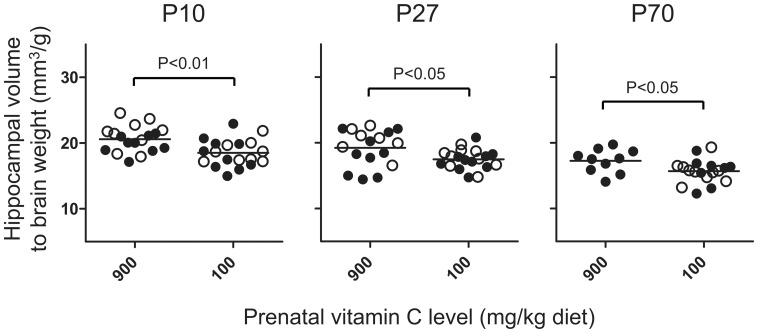
Persistently lower hippocampal volume corrected for brain weight in prenatally vitamin C-depleted animals.Results are presented as the grand mean for each prenatal treatment (i.e., either low or high). Closed circles (•) represent high and open circles (○) represent low postnatal vitamin C. At P10 and P27 there is a significant difference between prenatal diet group by two-way ANOVA, and by Student’s t-test at P70. N = 7–10 for each group.